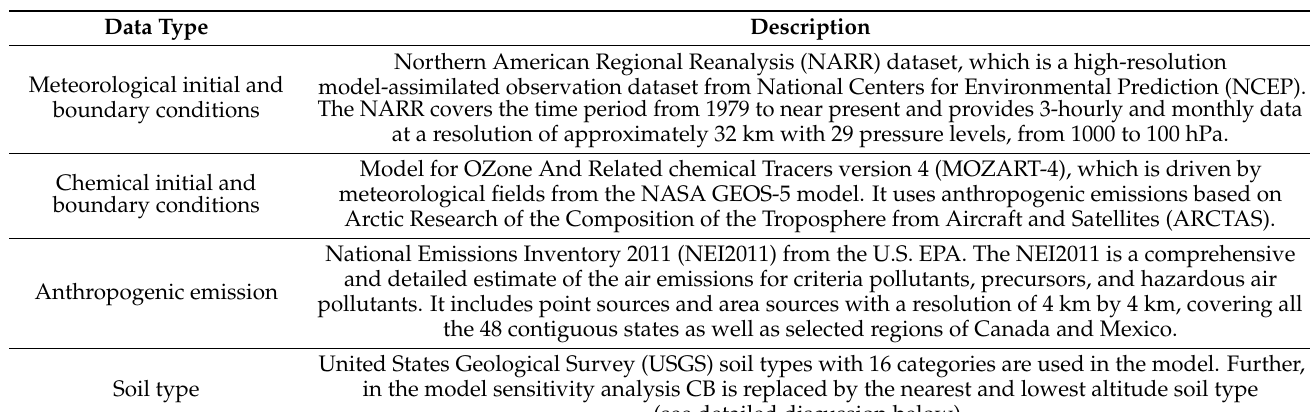
Table 1. Data used as inputs to WRF–Chem